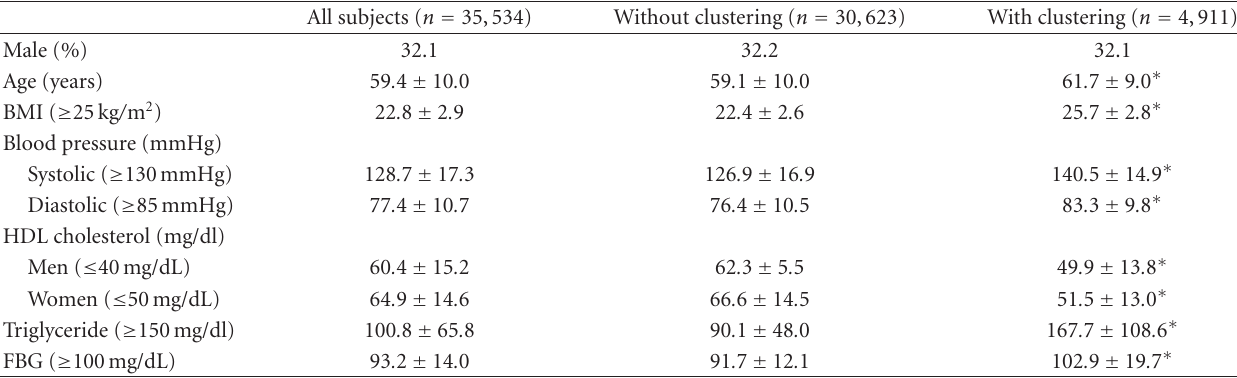
Table 1: Baseline characteristics of subjects with ( ≥ 3) and without clustering (0–2) of CVD risk factors.